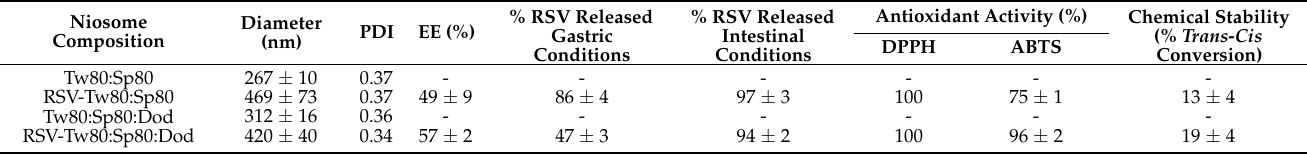
Table 1. Composition, mean diameter, polydispersity index (PDI) and encapsulation efficiency (EE) values, percent of RSV released, antioxidant activity and RSV chemical stability of niosomes prepared. ( ± SD, n = 3). Niosome